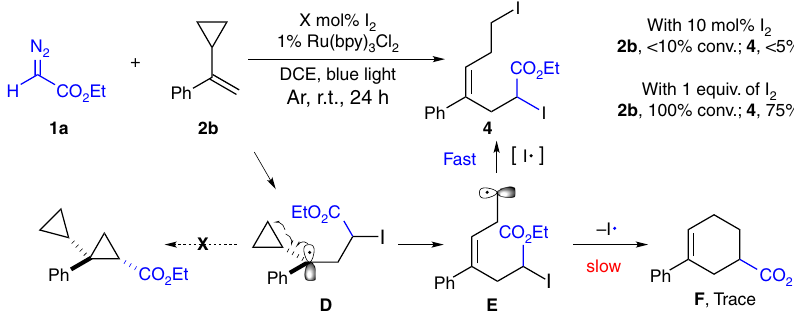
Fig. 3 Radical clock experiment. Proposed mechanism for the synthesis of